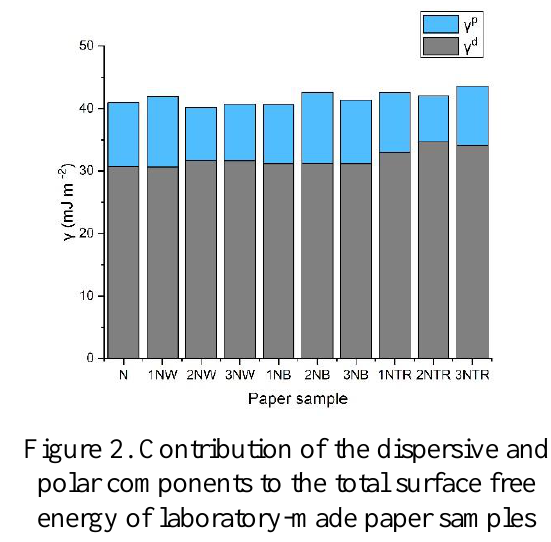
Figure 2. Contribution of the dispersive and polar components to the total surface free energy of laboratory-made paper